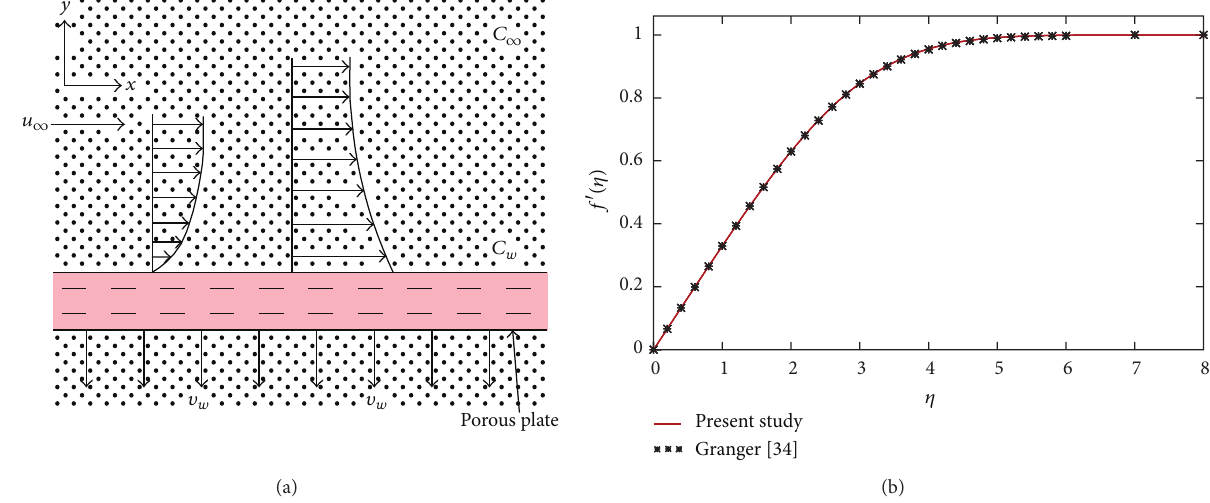
Figure 1: (a) Physical model of the boundary layer flow through porous medium on a flat plate. (b) Velocity profile 𝑓 󸀠 (𝜂) for 𝑘 ∗ = 0 and 𝑆 = 0